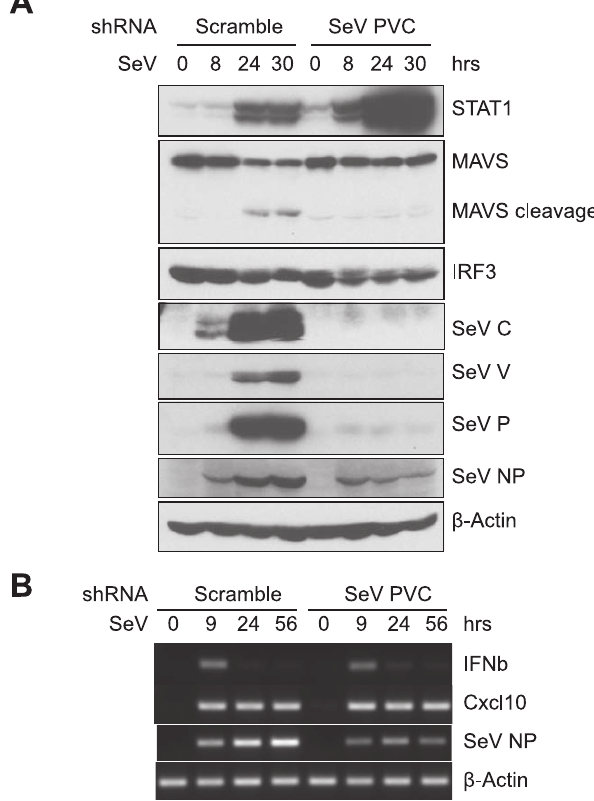
Figure 7. Interfering SeV replication with shRNA affects innate immune response. A . Targeting SeV by shRNA modulates the expression of critical factors in innate immunity. MEFs were treated with shRNA specifically targeting the SeV PVC gene or a scramble sequence shRNA as control. Cells were then infected with SeV. Total protein lysates were prepared after indicated time and separated on SDS-PAGE for western blot analyses with anti-STAT1, MAVS, IRF3, SeV C, V, P and NP and b -Actin antibodies. B . Targeting SeV by shRNA has minimal effects on IFN b expression kinetics. Experiments were conducted similarly as in A, but cells were harvested after indicated time for RNA extraction instead. The expression of IFN b , Cxcl10, SeV NP and b -Actin was analyzed by